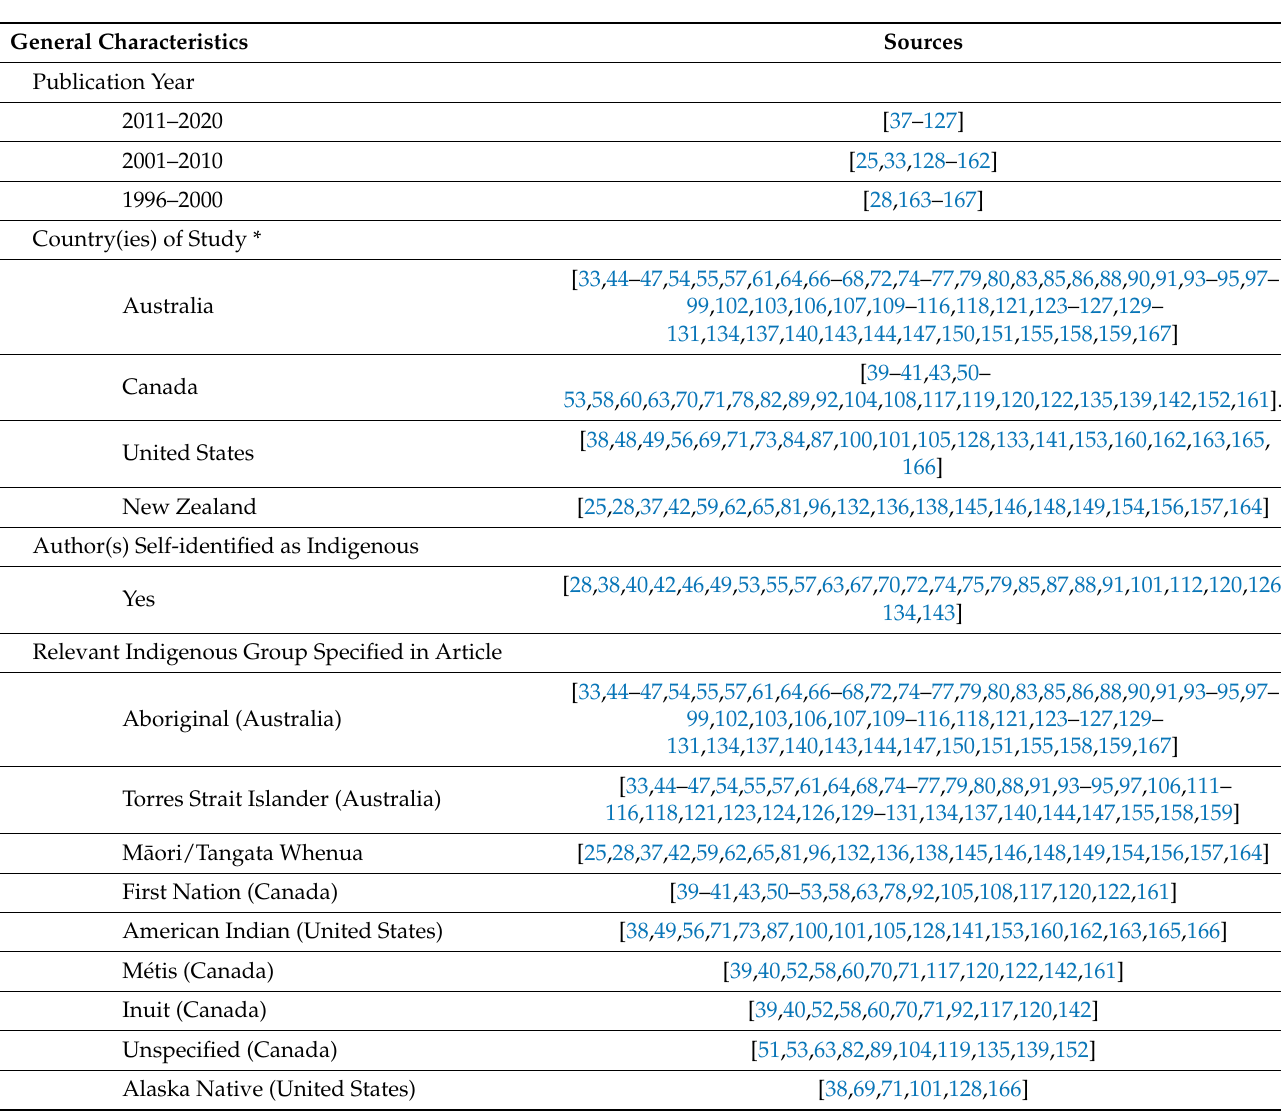
Table A3. Citations for General Characteristics of Sources of